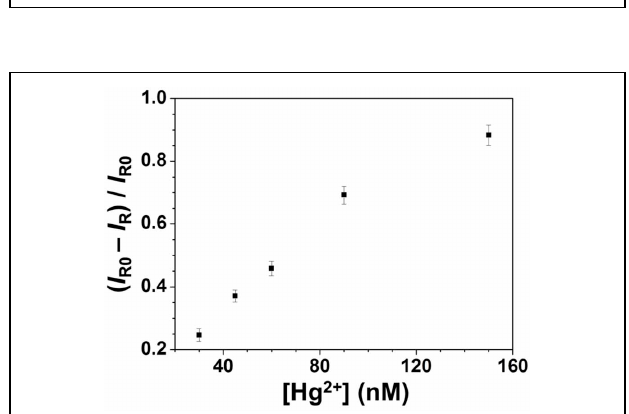
Figure 4 | Detection of Hg 2 + in a spiked pond water sample through SERS using Ag 2 Te NPs as a substrate. Concentrations of Hg 2 + ions ranged from 30 to